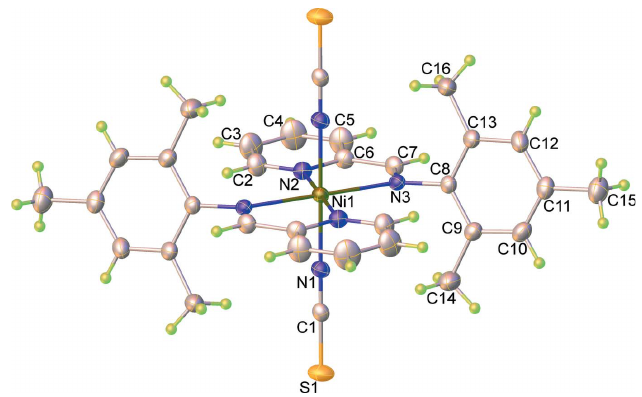
Figure 2 Molecular structures of the title complex ( II ), showing the atom-labelling scheme. Displacement ellipsoids are drawn at the 50% probability level.